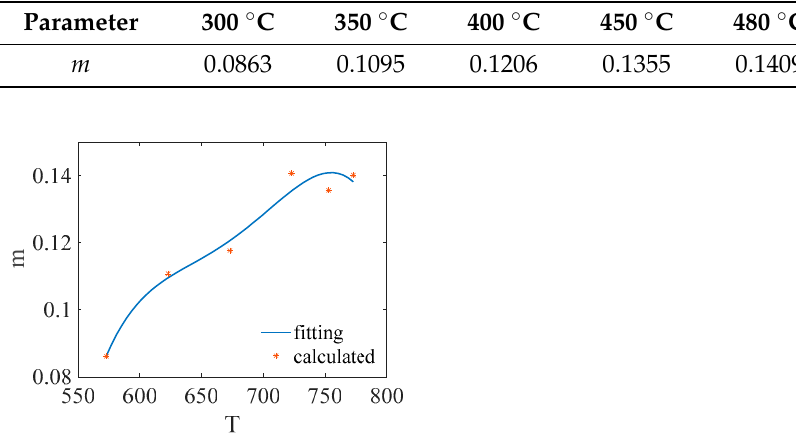
Figure 12. The value of the parameter m under different deformation temperatures. Table 6. The value of parameter m at different temperatures.